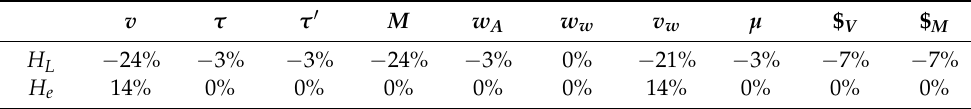
Table 6. The objective function elasticity coefficient.